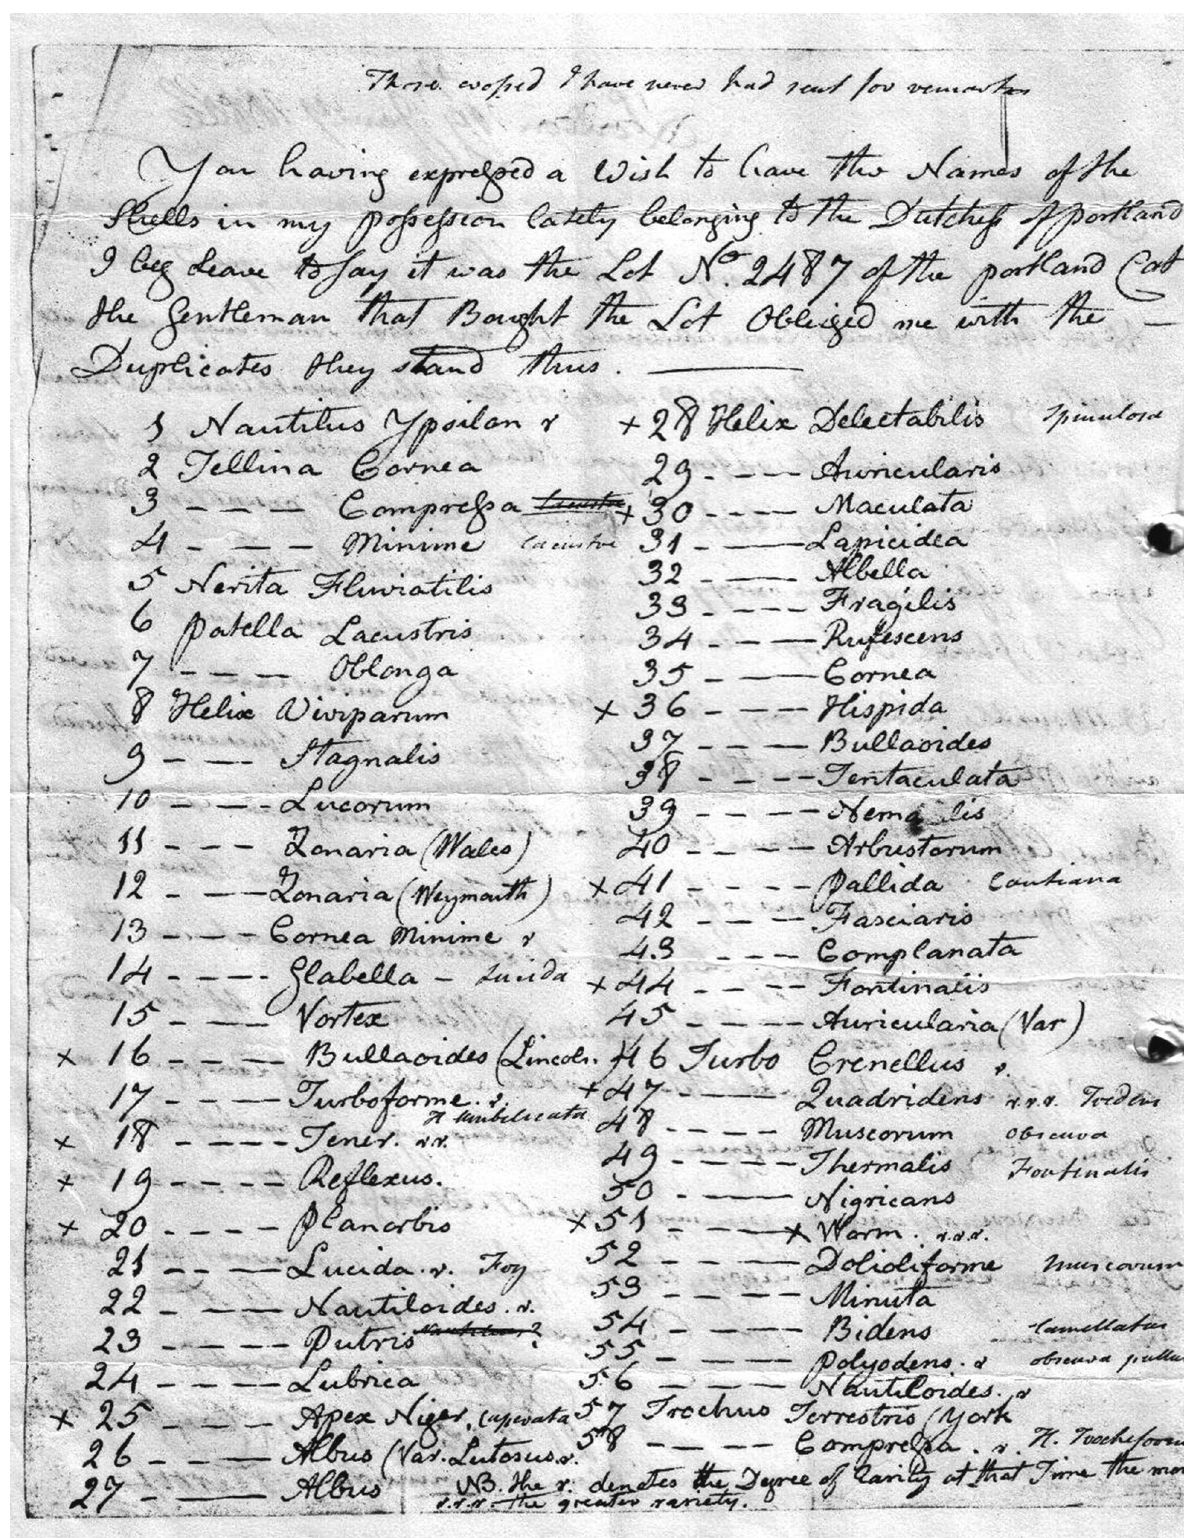
Figure I4. Part of a letter from Laskey to Montagu listing the shells in Laskey’s possession from lot 2487 of the Duchess of Portland collection. By permission of the Linnean Society of London, Archive